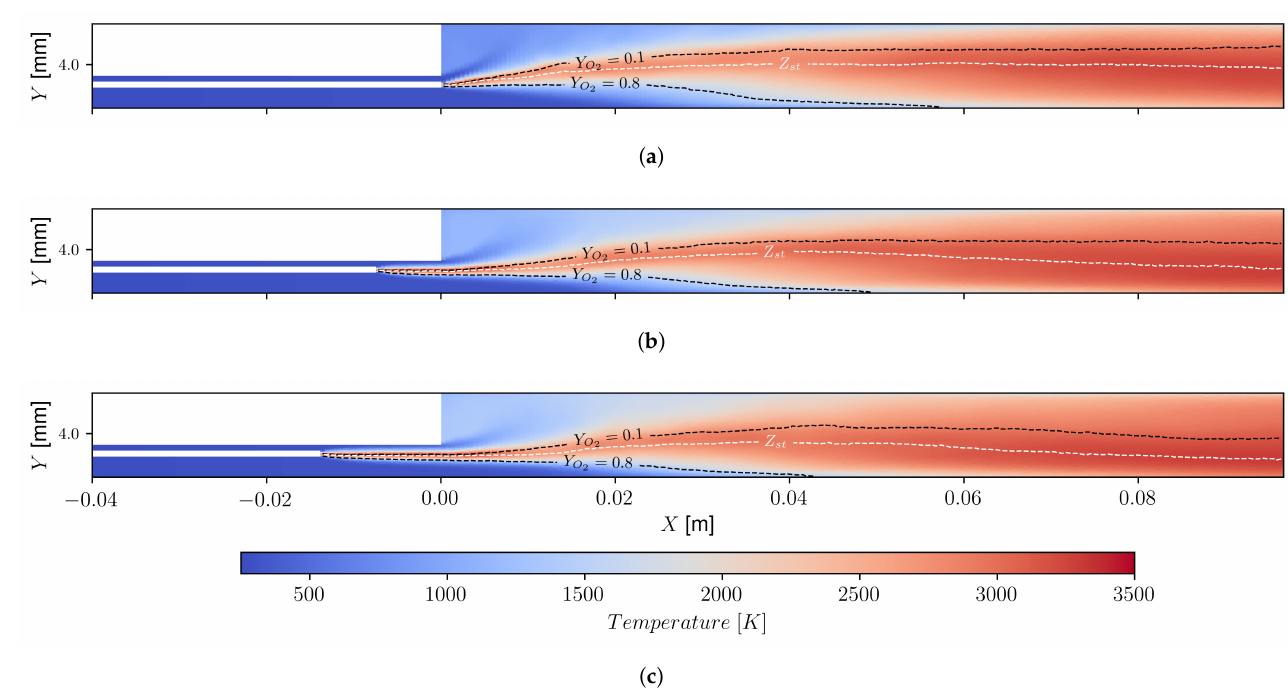
Figure 9. Ground-truth LES average temperature field interpolated into a 256 × 128 Cartesian grid. ∈ [ 0.1, 0.8 ] , Z st = 0.2 iso-lines have been overlaid for convenience. ( a ) DP-A, ( b ) DP-B, The Y O 2